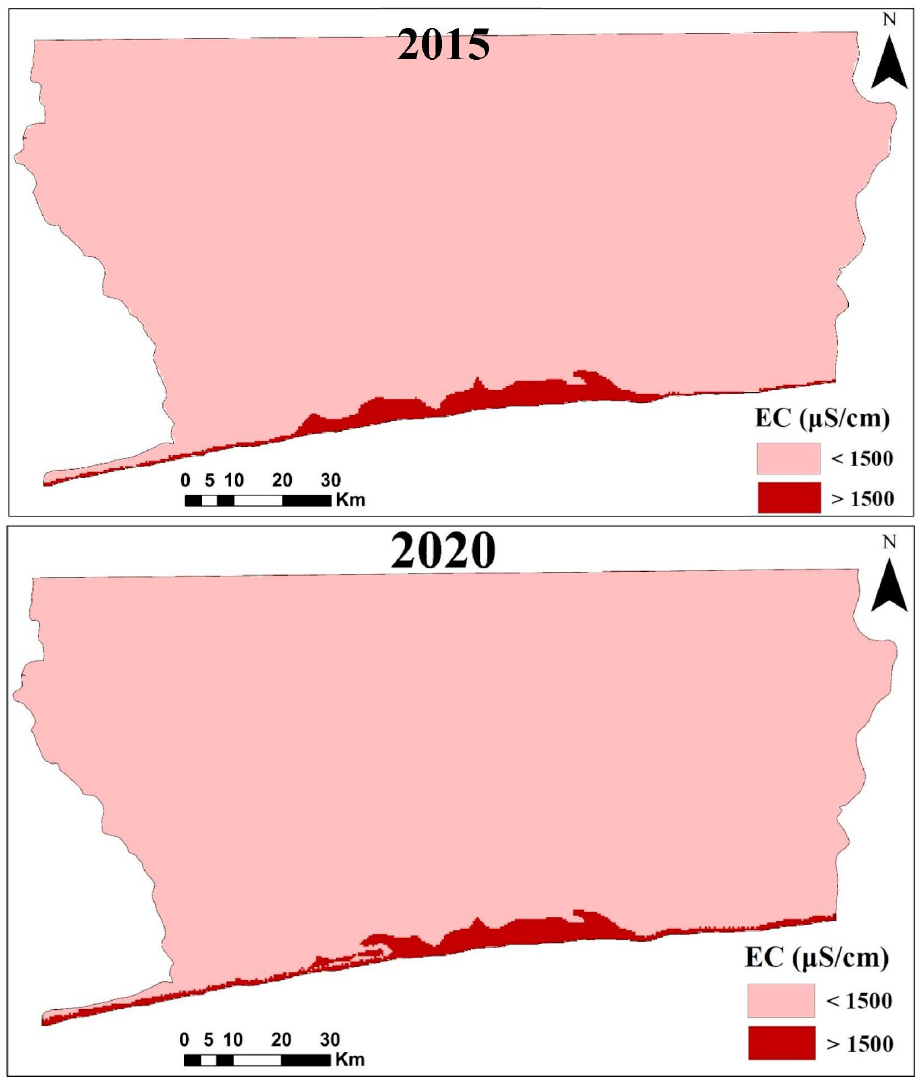
Figure 5. SWI area estimated in 2015 and 2020 using Visual MODFLOW.